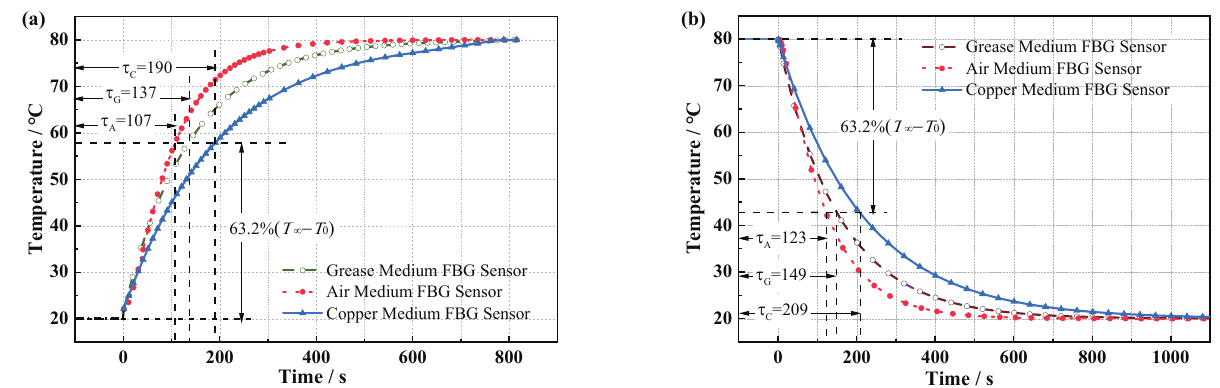
Figure 7. ( a ) Time response of positive temperature jump for FBG temperature sensor calculated by simulation. ( b ) Time response of negative temperature jump for FBG temperature sensor.